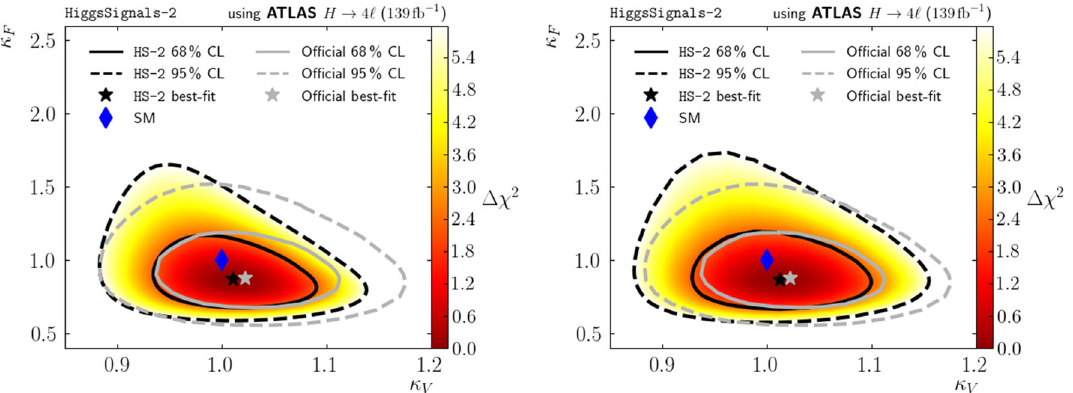
Fig. 11 Performance test in the ( κ V ,κ F ) parameter plane using the STXS measurements of the ATLAS H → Z Z analysis with 139 fb − 1 [62] as HiggsSignals input. Correlations of experimental uncertainties are included in both figures, while the correlations of the- oretical uncertainties on the STXS bin predictions are neglected (left